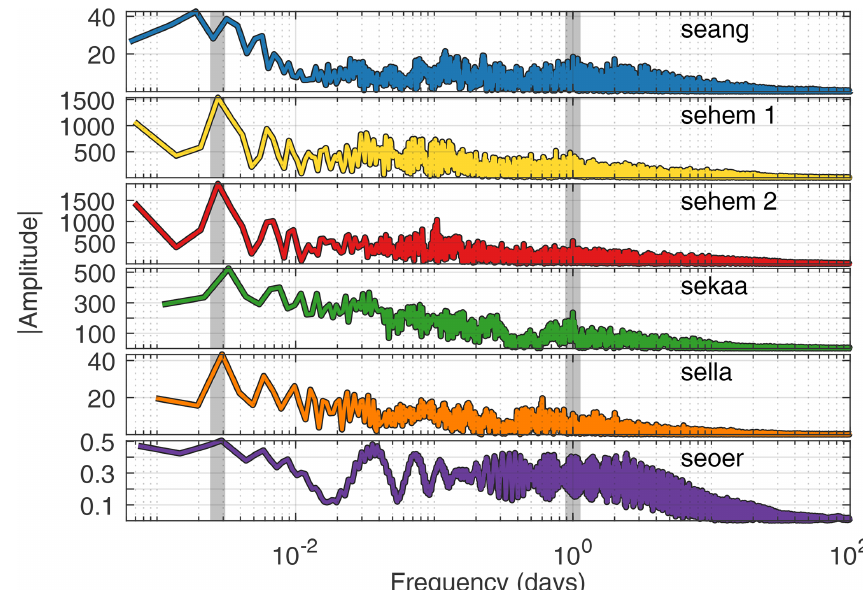
Figure 4. Spectral analysis of the median values of the reflectivity data from all radar cells in the selected areas. The 1-year and 1d periods are highlighted in the figure with gray vertical